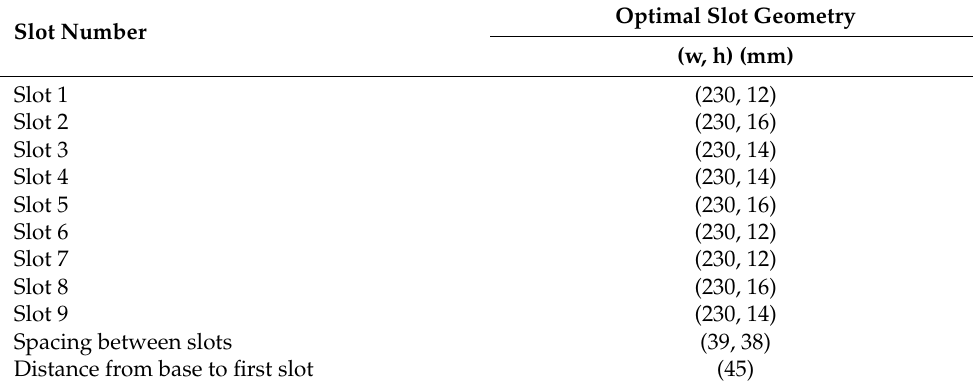
Table 4. Optimal baffle geometry for the four-chamber contact